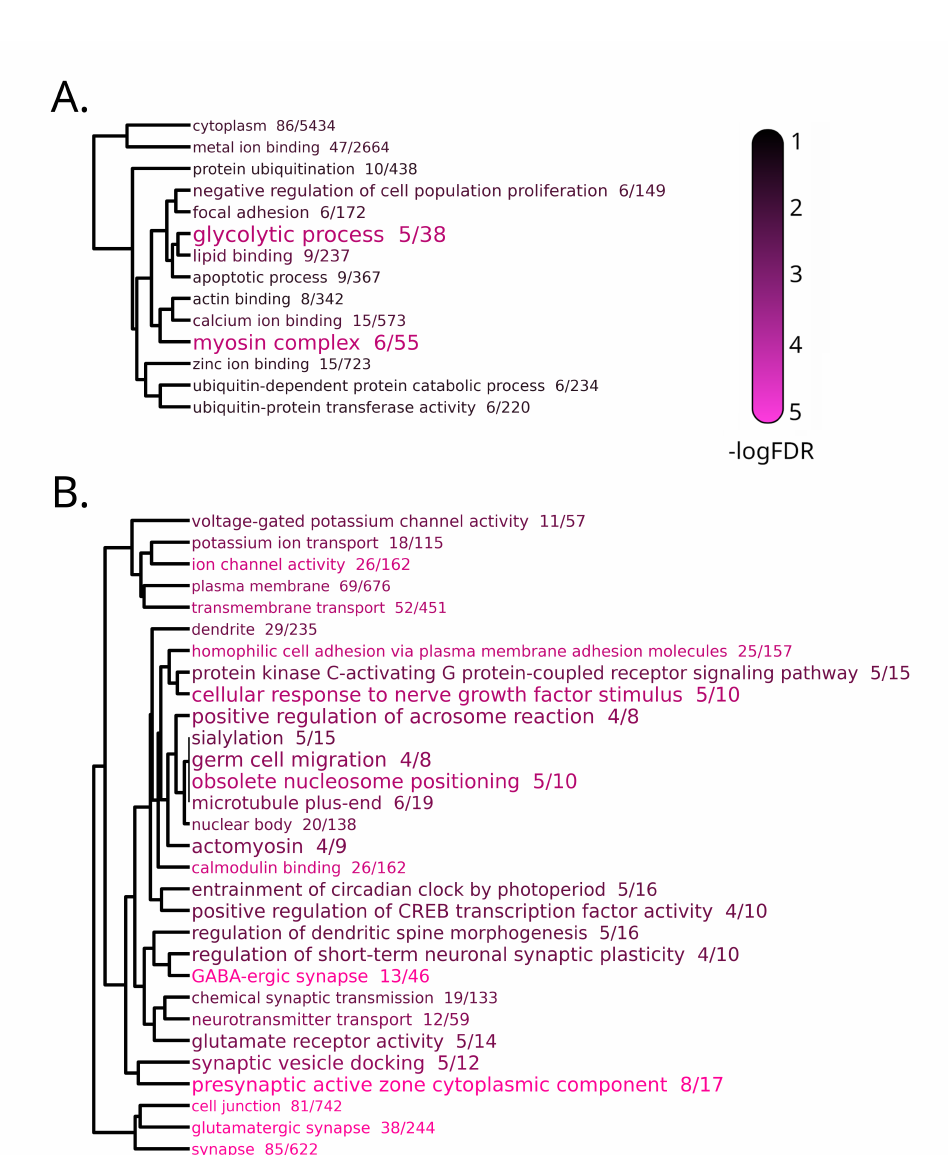
Figure 6. Dendrogram representation of complete linkage of overlapping DEGs associated with the top 30 most significantly enriched GO terms in clusters 0 ( A ) and 1 ( B ) of the transcriptomic response to stabling stress in brain. The size of the GO terms codes for the observed/expected value and the color scale for statistical